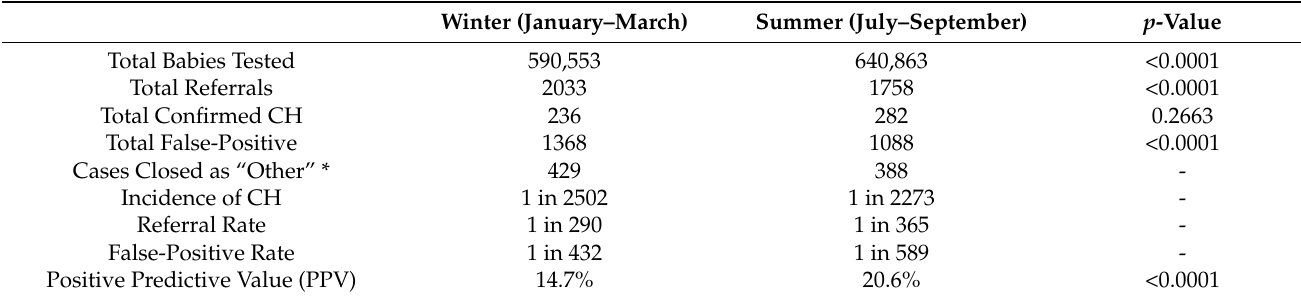
Table 1. Comparison between winter and summer for babies tested, referred, and false-positive cases from 2008 to 2017.